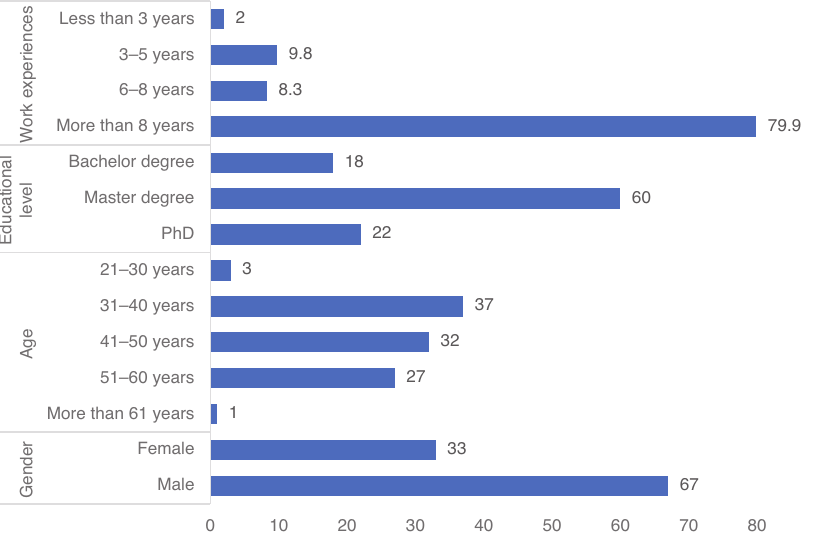
Fig. 4: Characteristics of the respondents (n =